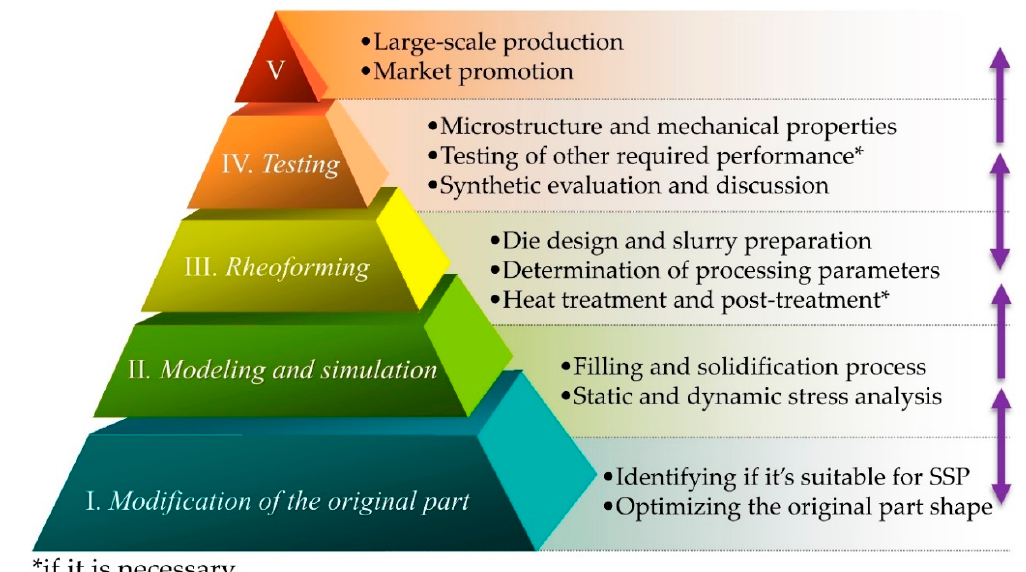
Figure 12. Flow chart of designing a new part for rheofoming to replace the original product.